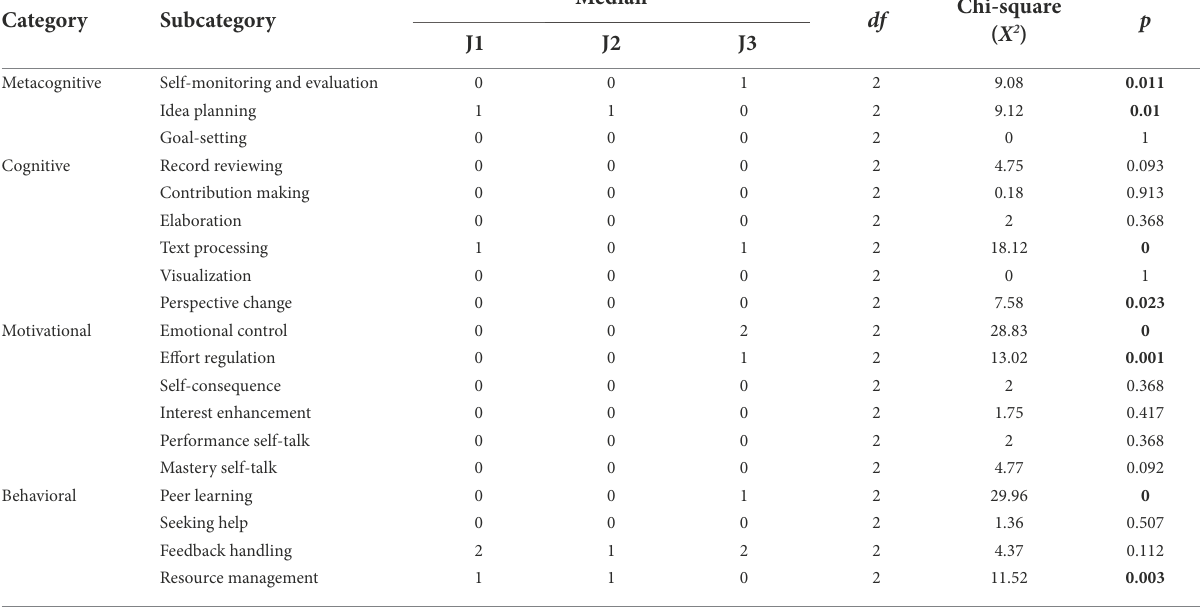
TABLE 4 Results of Friedman tests regarding the use of self-regulated writing strategies identified in reflective journals.